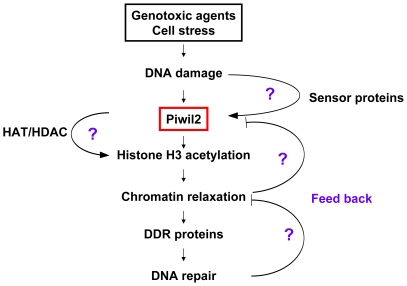
Schematic diagram of the role of Piwil2 for DNA repair.Once DNA damage is induced by genotoxic agents, silent PIWIL2 gene is activated, modulating chromatin relaxation through histone H3 acetylation to allow DNA damage signaling proteins and DNA repair proteins migrate to the sites of DNA damage. Thus, Piwil2 might control multiple down-stream pathways for DNA repair. It is possible that PIWIL2 could be activated by DNA damage sensor proteins to regulate histone H3 acetylation through effecting on HAT and/or HDAC. In addition, the proteins recruited to DNA damage sites might in turn suppress chromatin relaxation and Piwil2 expression after success of DNA repair (negative feedback). Overall, Piwil2 may mediate DNA repair through an axis of Piwil2 → histone acetylation → chromatin relaxation up-stream of DDR. DDR: DNA damage response; HAT: histone acetyltransferases; HDAC: histone deacetylase.